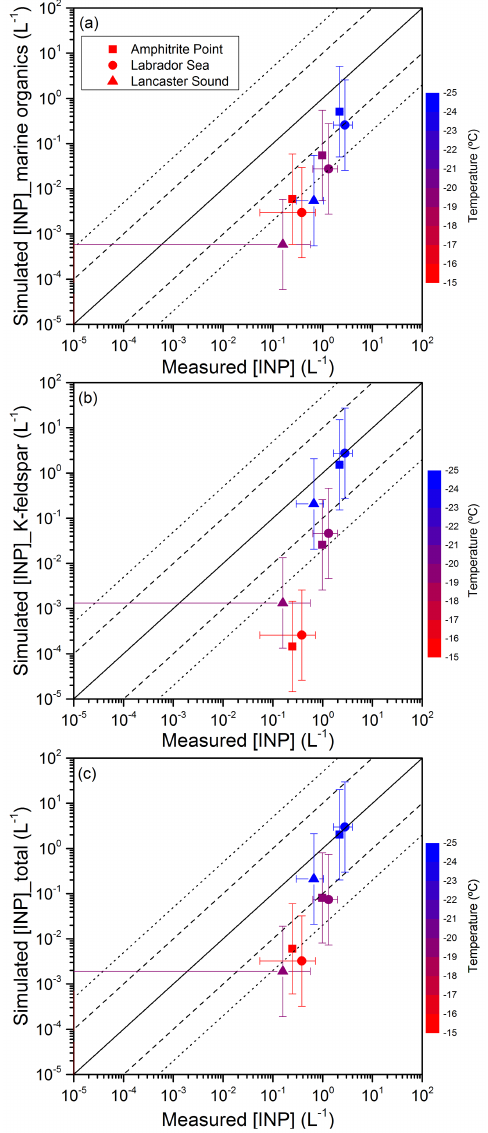
Figure 8. Comparison of measured INP concentrations and (a) sim- ulated INP concentrations from marine organics, (b) simulated INP concentrations from K-feldspar, and (c) simulated INP concentra- tions from both. The solid lines represent 1 : 1 ratio, the dashed and dotted lines represent 1 order and 1.5 orders of magnitude’s differ- ence, respectively. The temperature is shown using a colour scale. The simulated INP concentrations for Amphitrite Point, Labrador Sea, and Lancaster Sound correspond to mean concentrations for the months of August, July, and July, respectively. The uncertainties in the simulated concentrations are estimated to be around 1 order of magnitude, based on the parameterization and model uncertainty (Harrison et al., 2016; Wilson et al.,